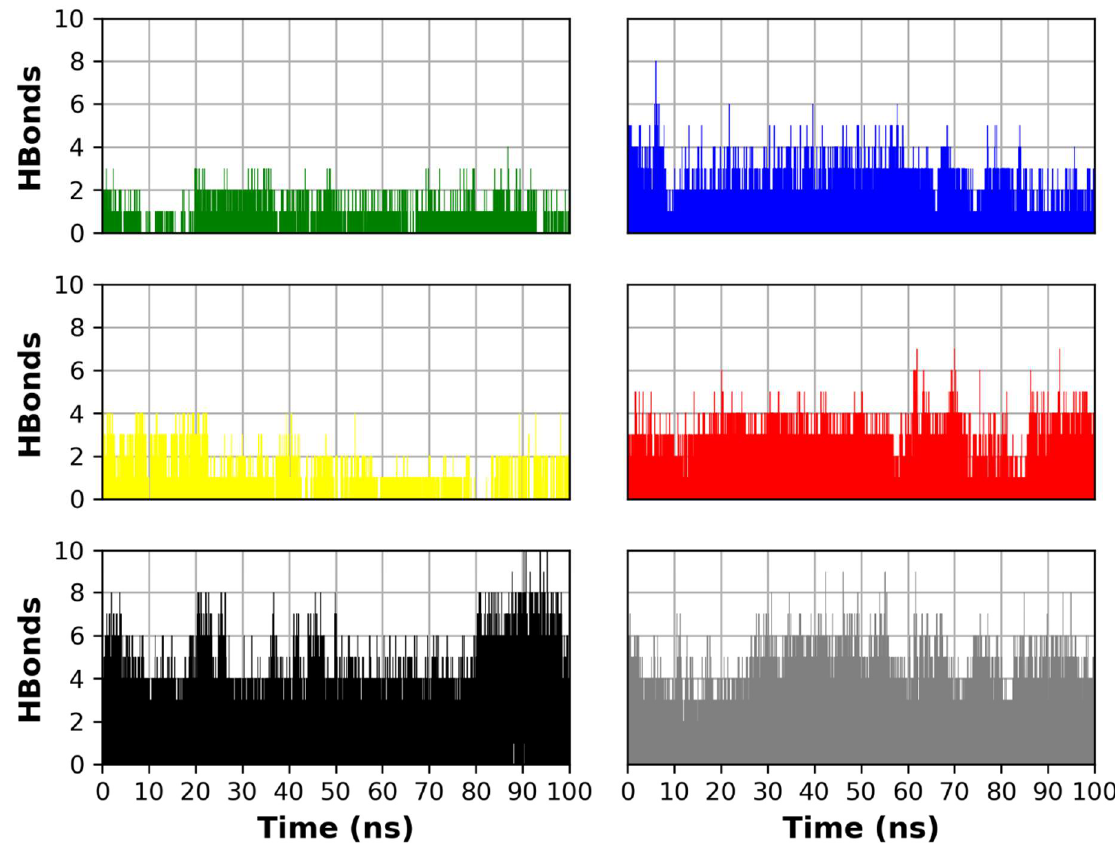
Figure 5. The number of H-bonds formed between each compound and the corresponding protein complex. (Green: complex 1 (ferulic acid), blue: complex 2 (rutin), yellow: complex 3 (gallic acid), red: complex 4 (chlorogenic acid), black: complex 5 (co-crystallized N3), gray: complex 6 (docked N3)).